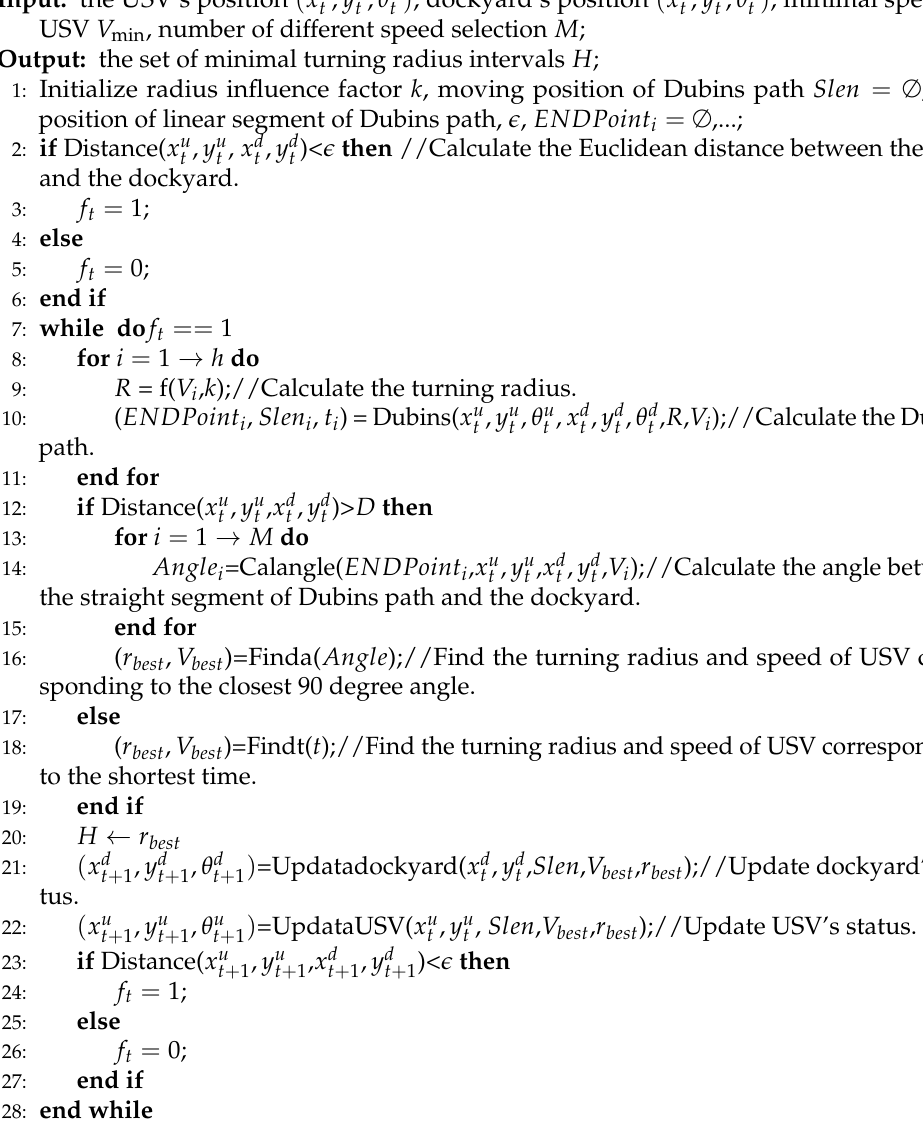
Algorithm 1 Automatic docking trajectory algorithm-based time-varying-radius Dubins